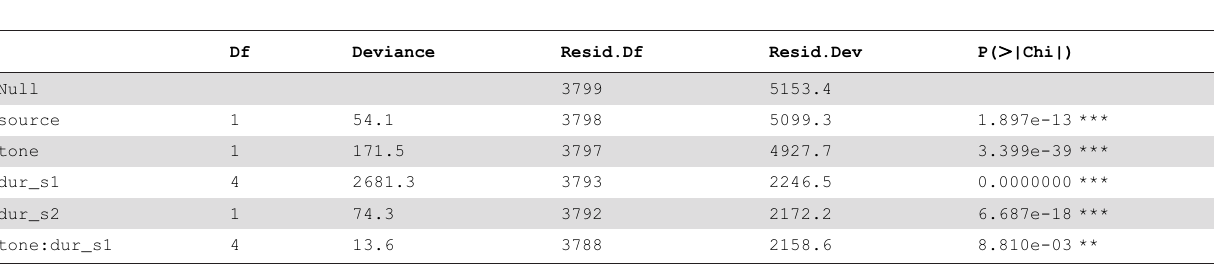
Table 2. Summary of the significance values for the factors source, tone, durations of the first syllable, and duration of the second syllable in Experiment 1 as obtained from the analyses of the deviance Table 1 (function anova(object, test = ‘‘Chisq’’) in R).